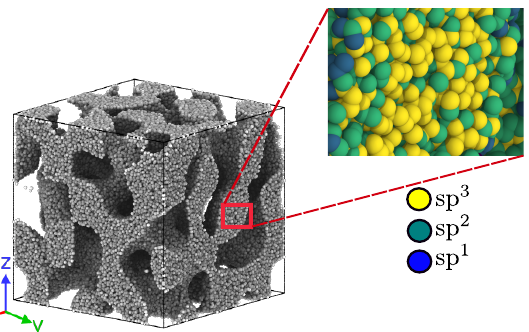
Figure 1. Nanofoam with a porosity of 50% and an sp 3 content of 49.1%. Inset shows the hybridization of the C atoms on the foam